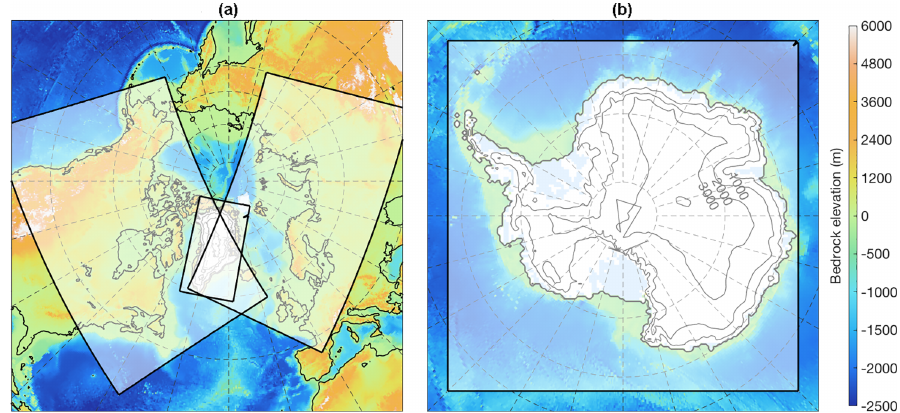
Figure 4. The areas of the world covered by the four model domains of ANICE2.1. In the North America and Eurasia domains, Greenland is